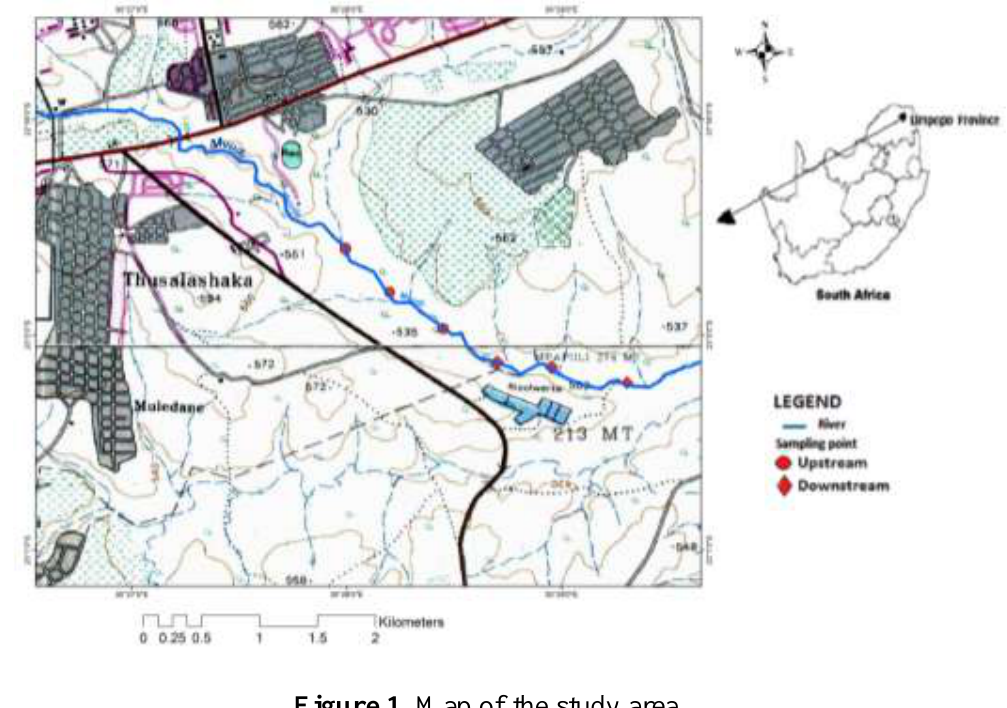
Figure 1. Map of the study